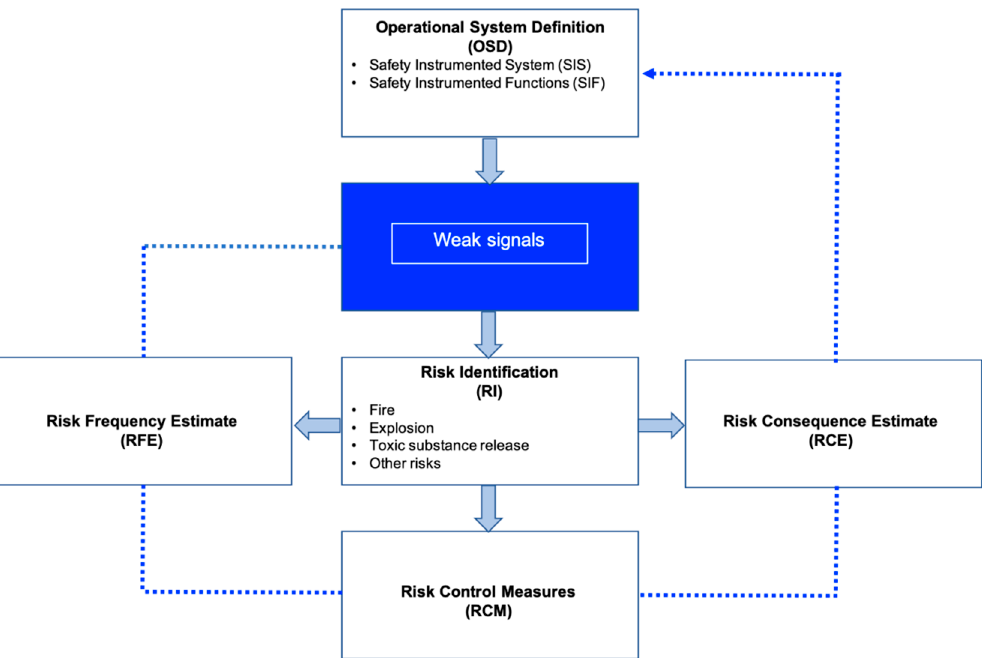
Figure 2. Impact of weak signals in the process safety risk analysis digitalization method. The present figure has been adopted and modified from the work of Benson et al. [24].